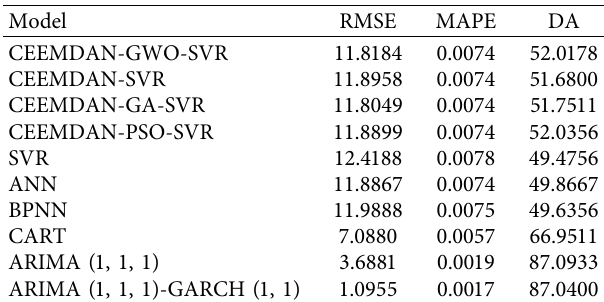
Table 6: In-sample forecasting accuracy measures of the CEEM- DAN-GWO-SVR and benchmark models.